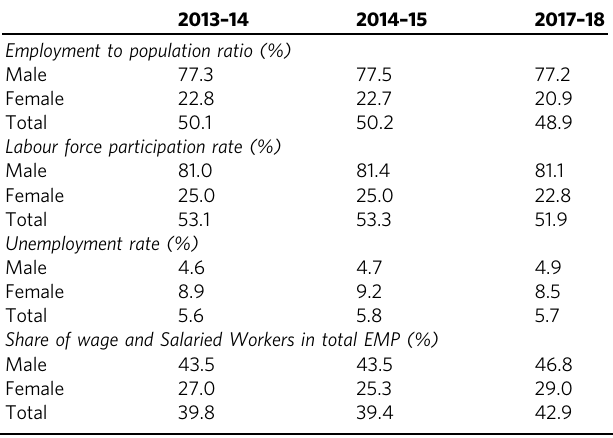
Table 1 Selected labour market